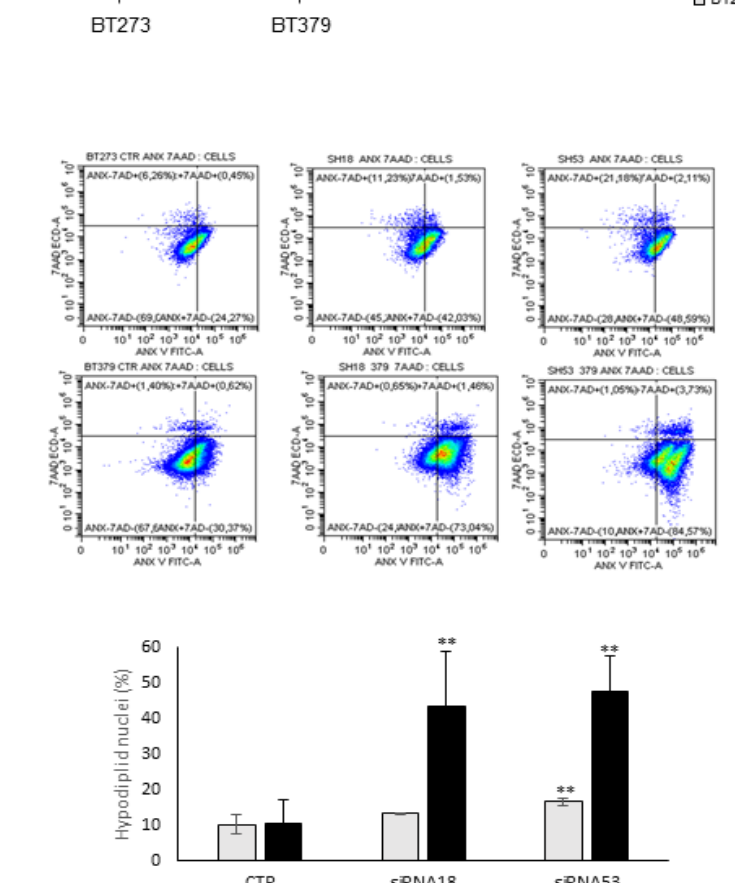
Figure 2. MEOX2 depletion induces the apoptosis of glioblastoma stem cells BT273 and BT379. ( a ). Cleaved Caspase-3 Western blot analysis of BT273 and BT379 cells transduced with shRNA18 or shRNA53 or ctrl lentiviral constructs. Total Caspase-3 is shown. β -actin was used as the